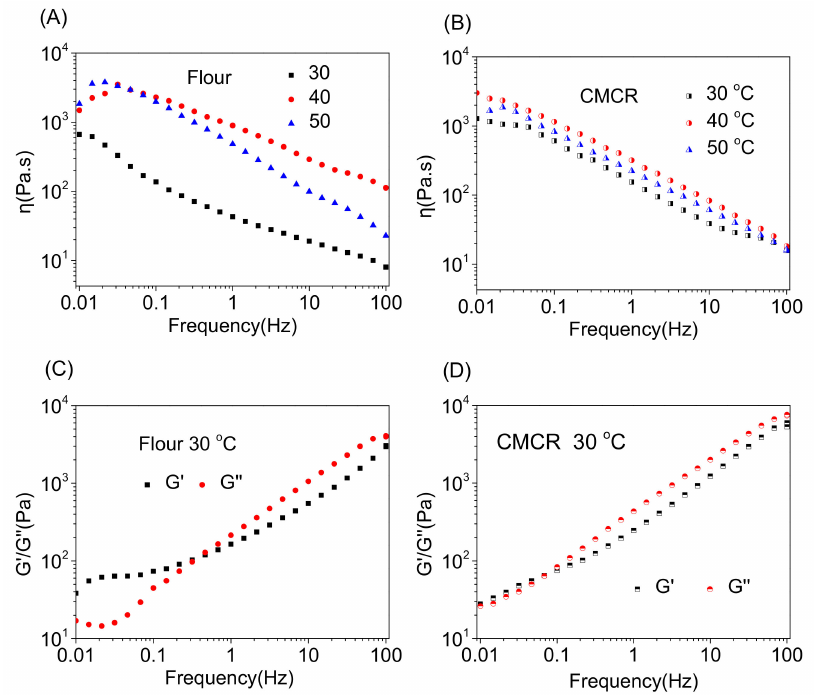
Figure 5. Viscosity-frequency curves of flour ( A ) and CMCR ( B ) at di ff erent temperatures; and viscoelasticity–frequency curves of ( C ) flour and ( D ) CMCR at 30 ◦